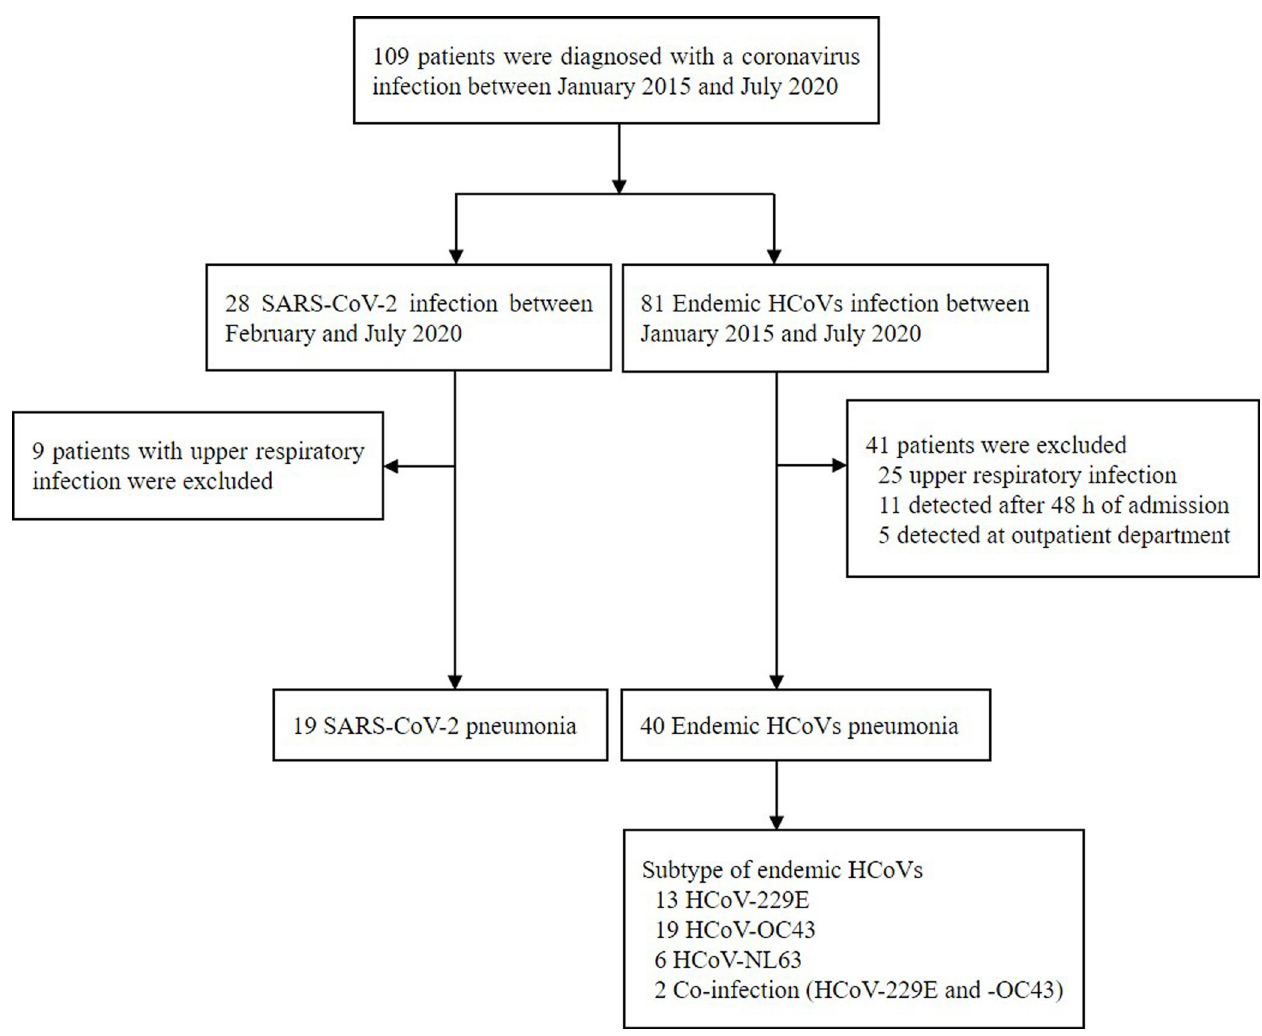
Fig 1. Flow chart of the patients. COVID-19, coronavirus disease; and HCoV, human coronavirus.